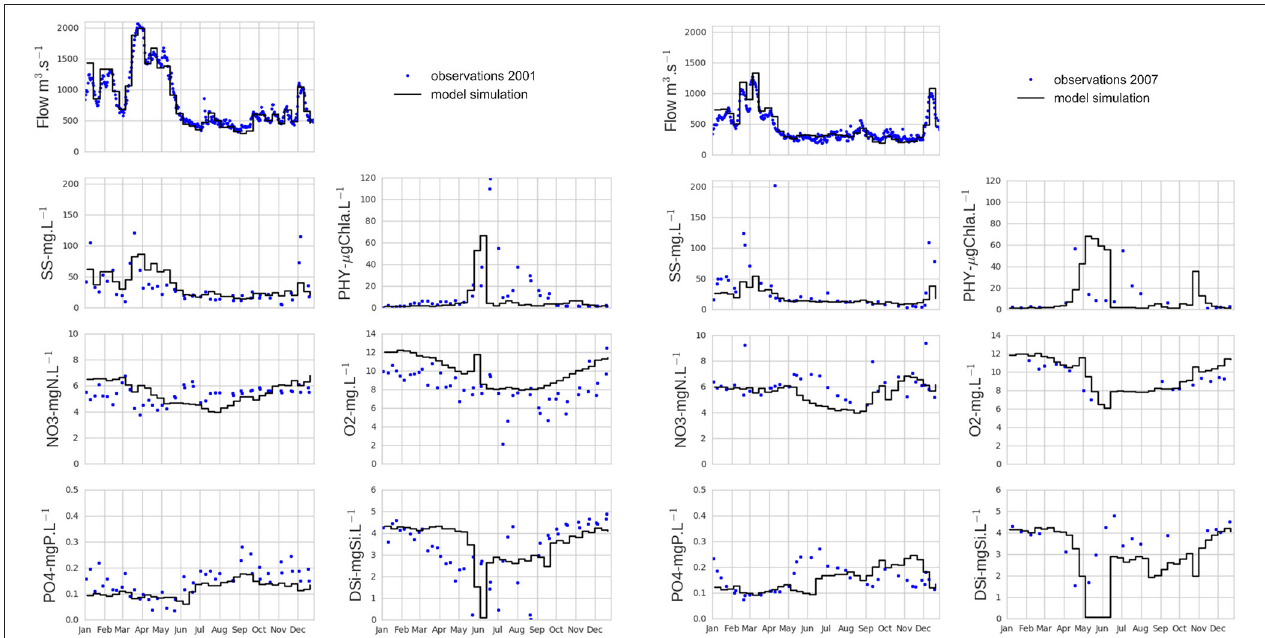
FIGURE 2 | Measured and modeled time series of hydro-biogeochemical variables (streamflow, suspended solids, nitrate, phosphate, phytoplankton, dissolved oxygen, silicic acid) at Poses at the outlet of the Seine River basin during two wet (2001, left ) and dry (2007, right ) years. Discharge and water quality measurements were provided by the Banque Hydro (http://www.hydro.eaufrance.fr/) and the French water authority (Agence de l’Eau Seine-Normandie), respectively.